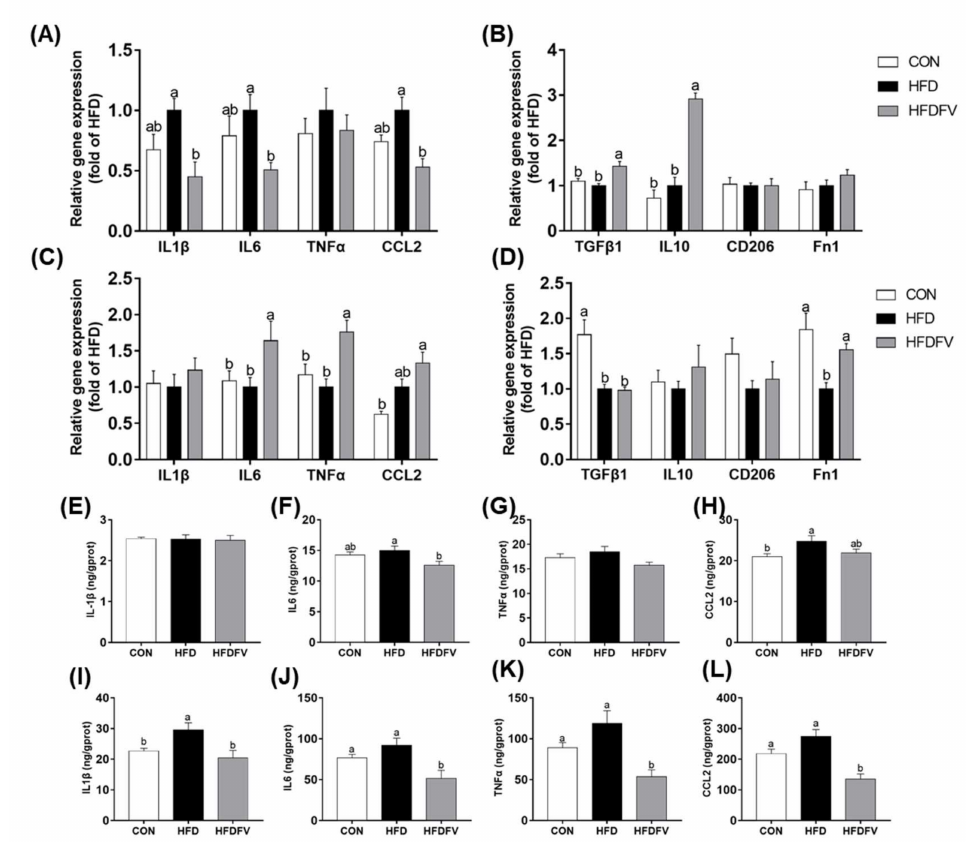
Figure 5. Effects of FV mycorrhizae on HFD-induced inflammatory cytokines in the liver and PAT of mice. ( A ) Gene expression of pro-inflammatory cytokines in the liver; ( B ) Gene expression of anti-inflammatory cytokines in the liver; ( C ) Gene expression of pro-inflammatory cytokines in the PAT; ( D ) Gene expression of anti-inflammatory cytokines in the PAT; ( E – H ) The contents of pro-inflammatory cytokines in the liver; ( I – L ) The contents of pro-inflammatory cytokines in the PAT. Values with different letters differ significantly ( p < 0.05). Values were expressed as mean ± SEM ( n =